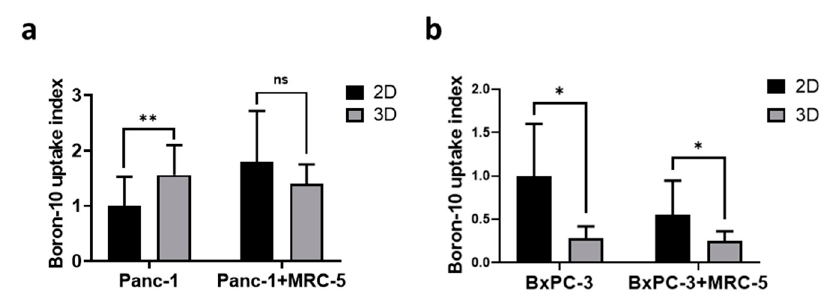
Figure 3. The monolayer culture exhibited higher boronophenylalanine (BPA) uptake than that of the 3D tumoroid model. The relative BPA uptake in ( a ) Panc-1 and ( b ) BxPC-3 spheroids and mon- olayer cells. The BPA uptake was normalized to 2D culture groups. Statistical significance was de-